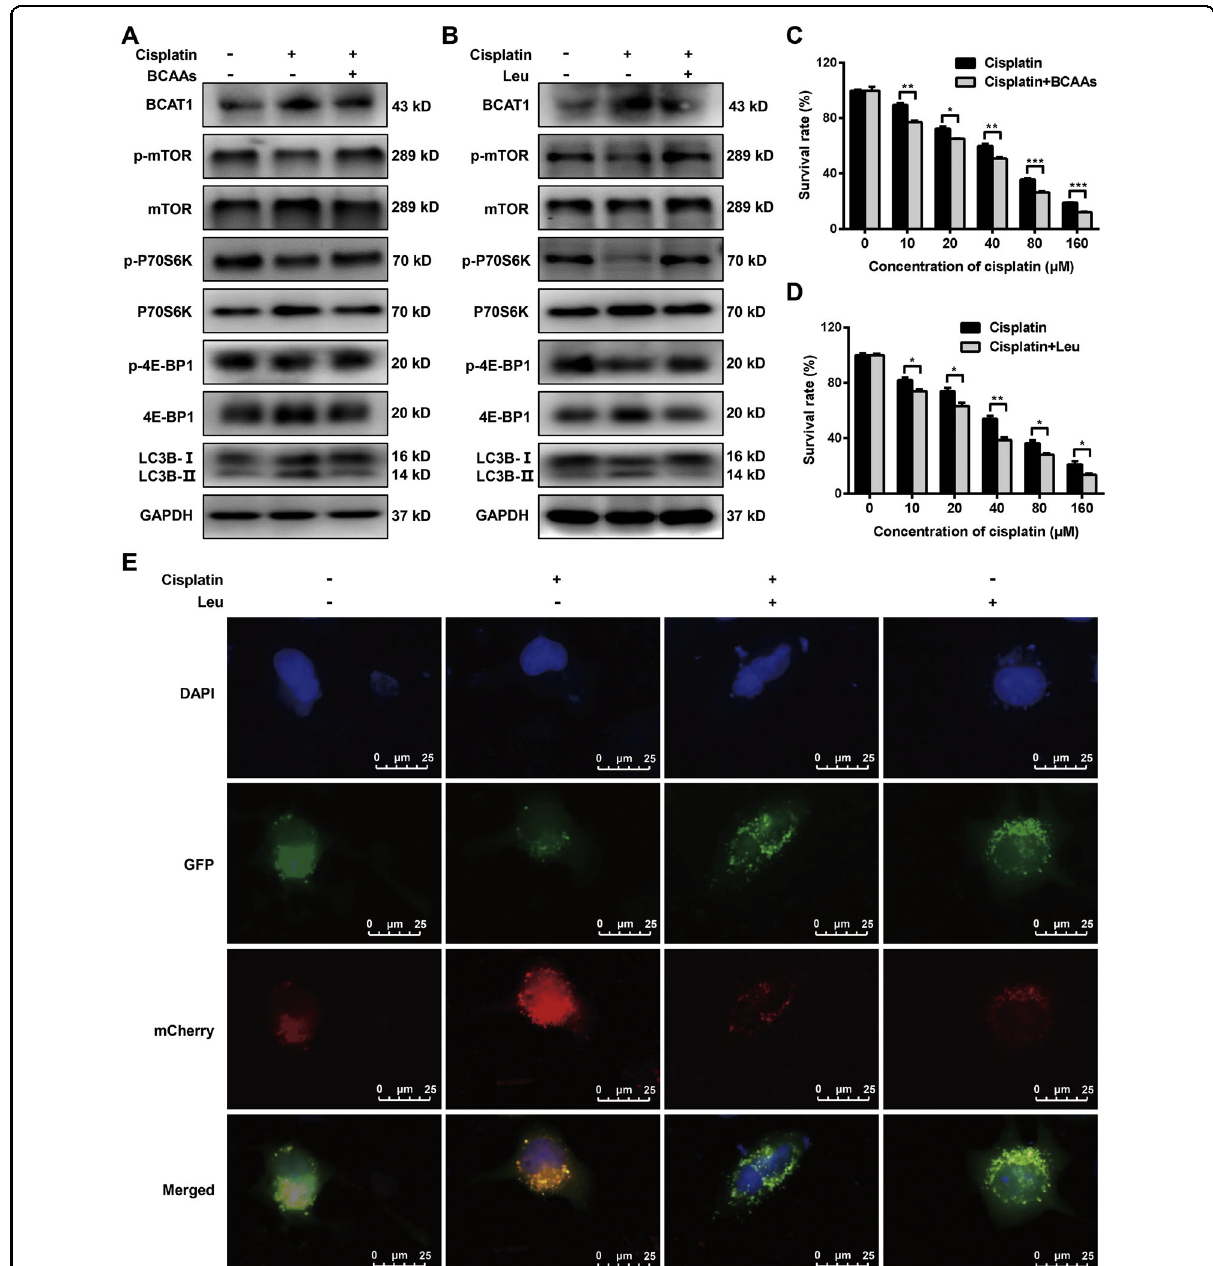
Fig. 4 Branched-chain amino acids (BCAAs) and leucine (Leu) decrease cisplatin-mediated autophagy and increase cisplatin sensitivity. A , B Western blot analysis of the protein levels of BCAT1, mTOR, p70S6K, 4E-BP1 and their phosphorylated counterparts and LC3-I/II in Hela cells treated with cisplatin (20 μ M) or in combination with BCAAs (5 mM) or Leu (2 mM) for 24 h. C , D Hela cells were treated with increasing concentrations of cisplatin alone or in combination with BCAAs (5 mM) or Leu (2 mM) for 24 h. Cell viability was assessed by CCK-8 assays. E Representative image of Hela cells transfected with pCMV-mCherry-GFP-LC3B. The cells were treated with cisplatin (20 μ M) or Leu (2 mM) alone or together for 24 h. Scale bars: 25 μ m. Three independent experiments were performed. * P < 0.05, ** P < 0.01, *** P <